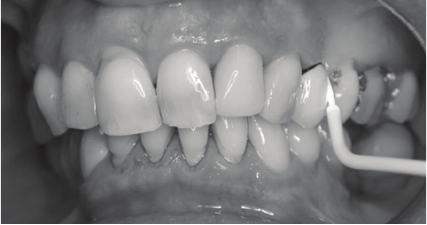
Figure 4: Exposure to HELBO TheraLite diode laser for about 1 minute of the implant surface.